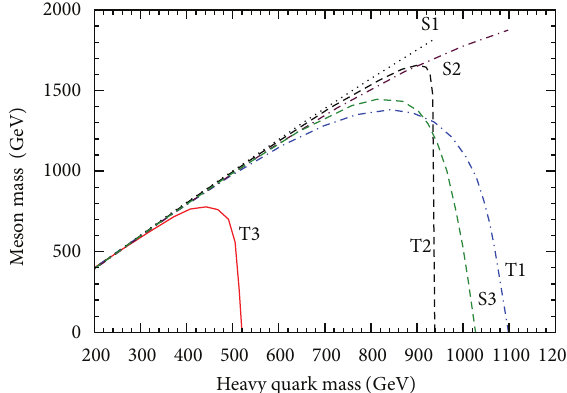
Figure 2: The masses of color singlet isotriplet 𝜋 and isosinglet states versus the 4G quark mass from [17] in various formalisms. Curves S1 (iso-singlet 𝜔 1 ) and T1 (isotriplet 𝜋 1 ) are the results from covariant gauge formalism. S2 (isosinglet) and T2 (isotriplet) are the results from Salpeter’s equation using only positive frequency components. S3 (isosinglet) and T3 (isotriplet) are the results using both positive and negative frequency components. For more details of these formalisms see [17].